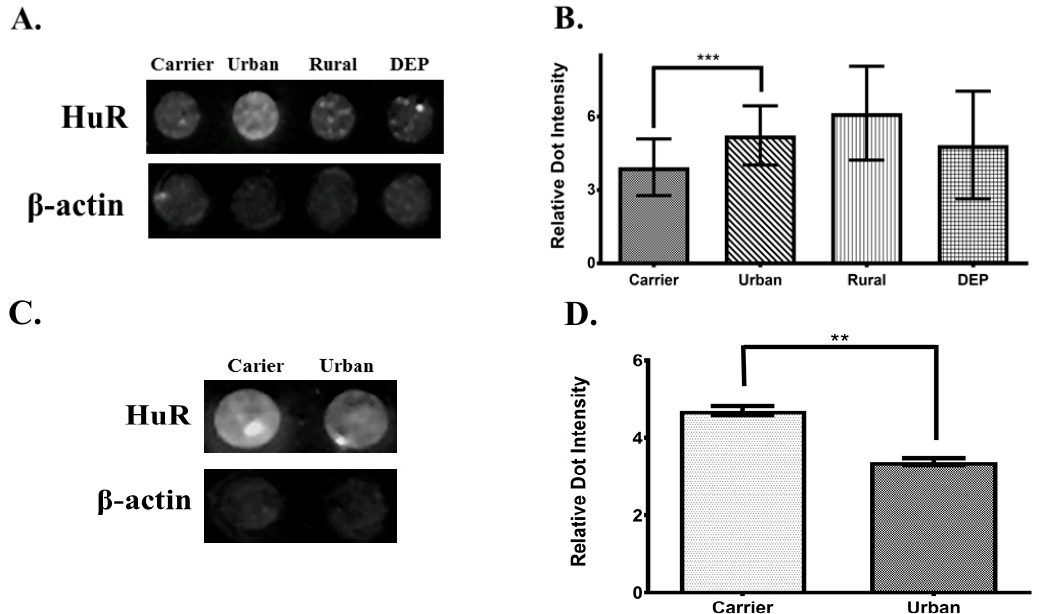
Figure 7. Cytoplasmic abundance of ELAV-L protein 1 (HuR) after 15 min and 1 hr of exposure. ( A ) Dot blot of HuR and actin (loading control) after 15 min of exposure in cells treated with 25 µg/mL of both, rural and urban organic extracts and 10 µg/mL of DEP organic extract. ( B ) Densitometric analysis of cytoplasmic HuR dot blots from cells treated with DEP extract. ( C ) Dot blot of HuR and actin after 1 hr of exposure in cells treated with 25 µg/mL of urban organic extract. ( D ) Densitometric analysis of HuR dot blots from cells treated with the urban extract. Figure represents the average of three independent experiments ( n = 3). Values are expressed as the mean ± SEM ( n = 3). ** p ≤ 0.01, *** p ≤ 0.001 compared to carrier.